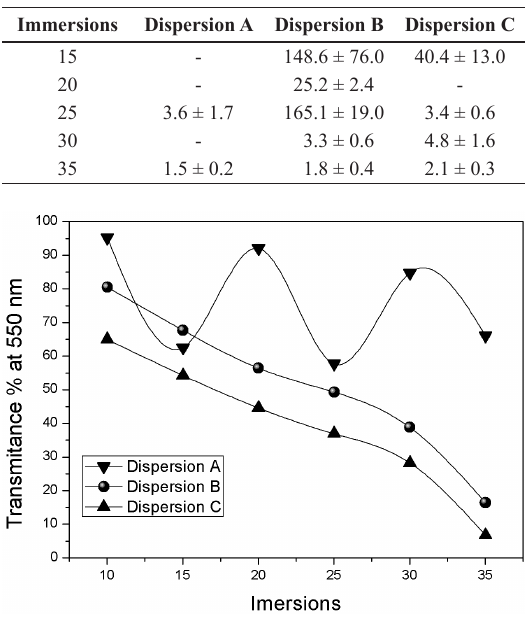
Figure 2. Percentage of light transmitted in 550 nm to (A), (B) and (C) dispersions as a function of immersions. The lines connecting the experimental points are guide for